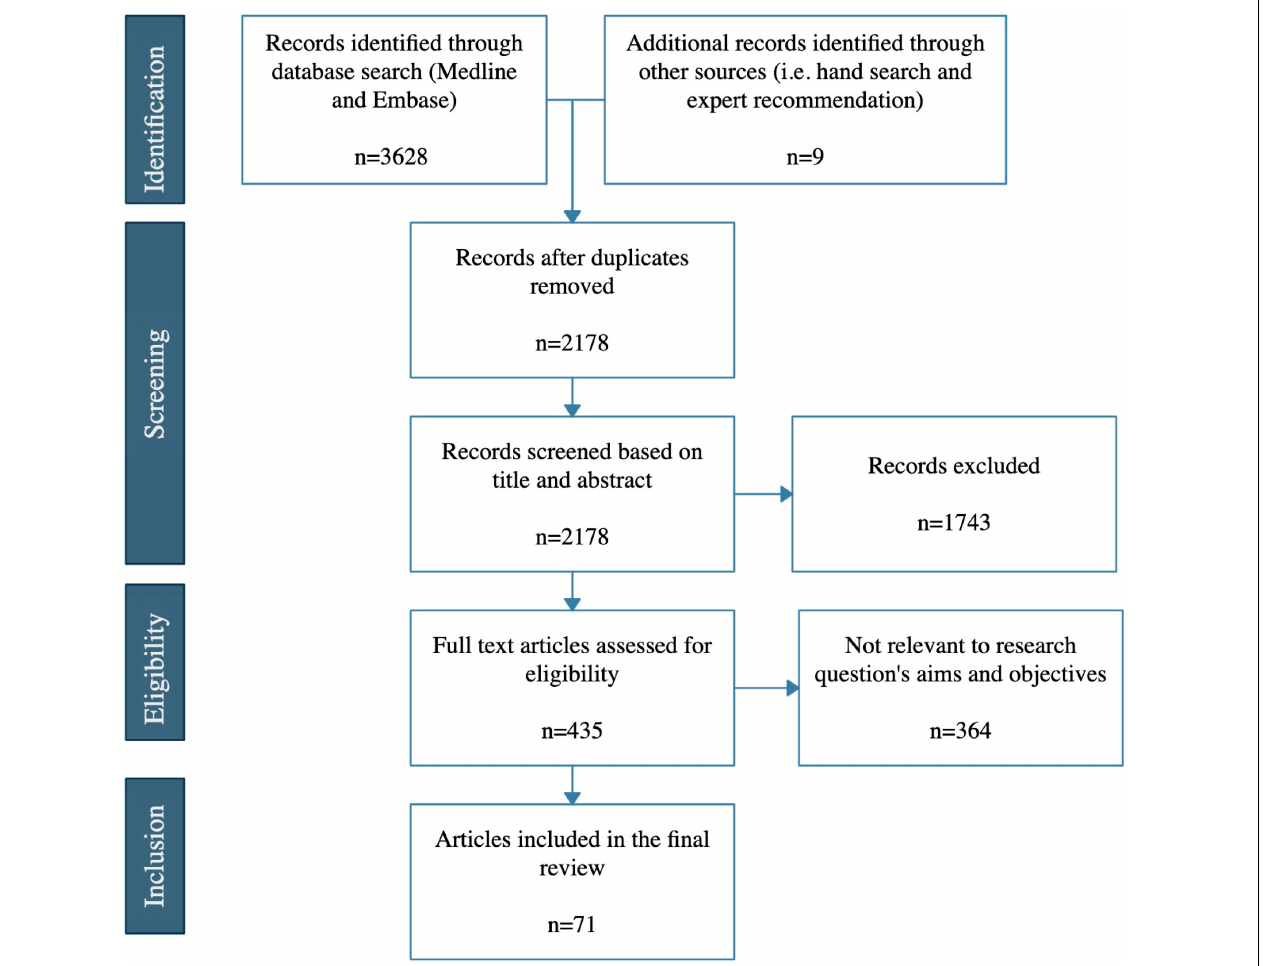
FIGURE 3 | Prisma flow